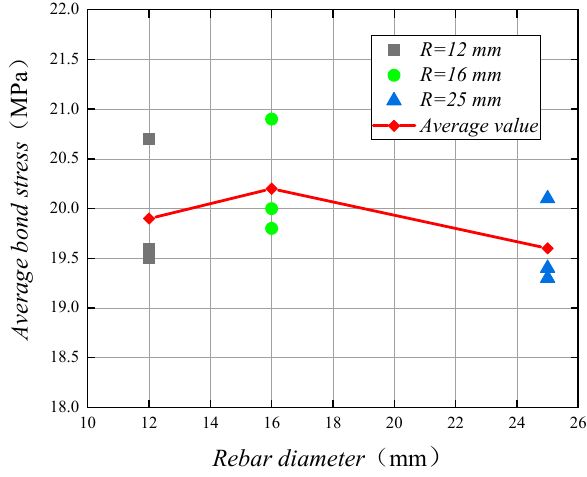
Figure 8. The bond stress and stainless steel bar diameter relationship curve.